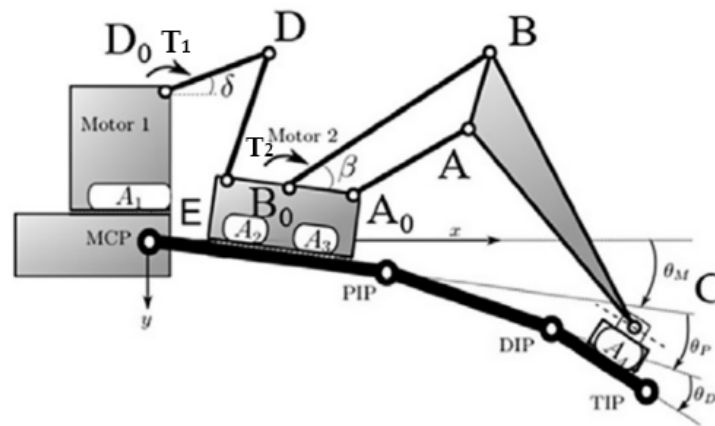
Figure 1. Kinematic design of the proposed ExoFinger exoskeleton, [28].